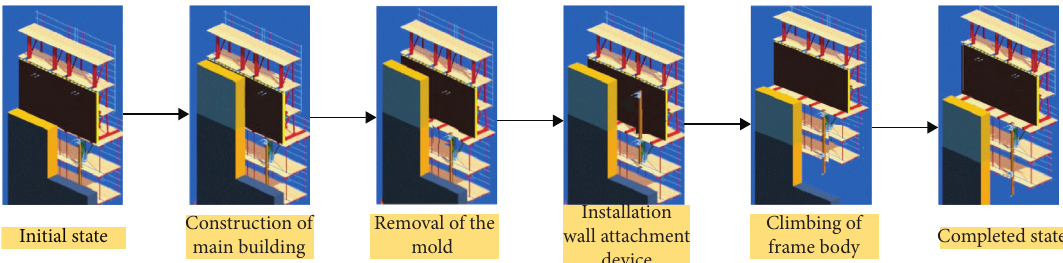
Figure 2: The construction process of RIM-SCS80 climbing formwork.